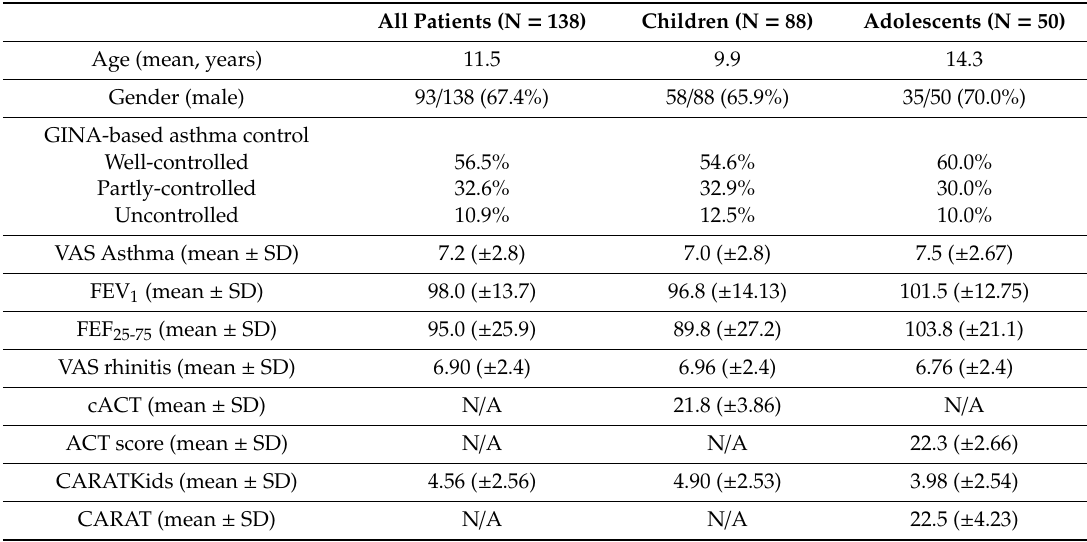
Table 1. Demographic and clinical data in asthmatic children and